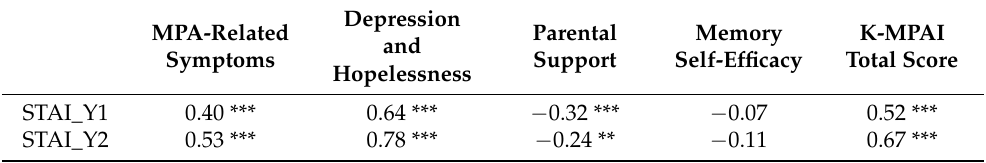
Table 3. Pearson correlation between STAI and K-MPAI factors.